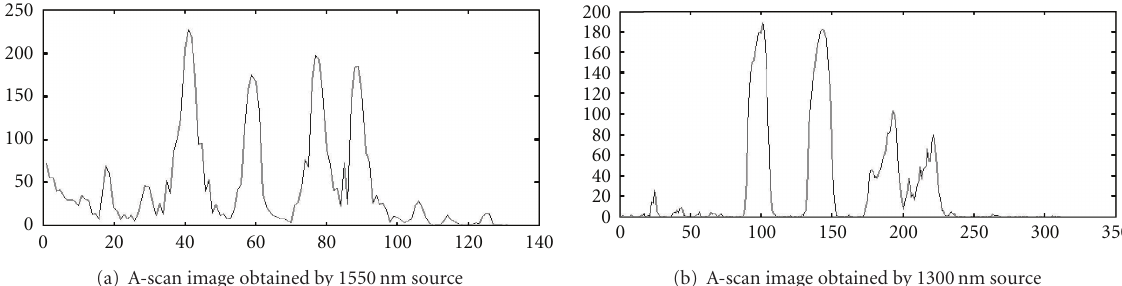
Figure 5: A-scan OCT images of a 4-layer glass sample. (a) A-scan image obtained by 1550 nm source; (b) A-scan image obtained by 1300 nm source.